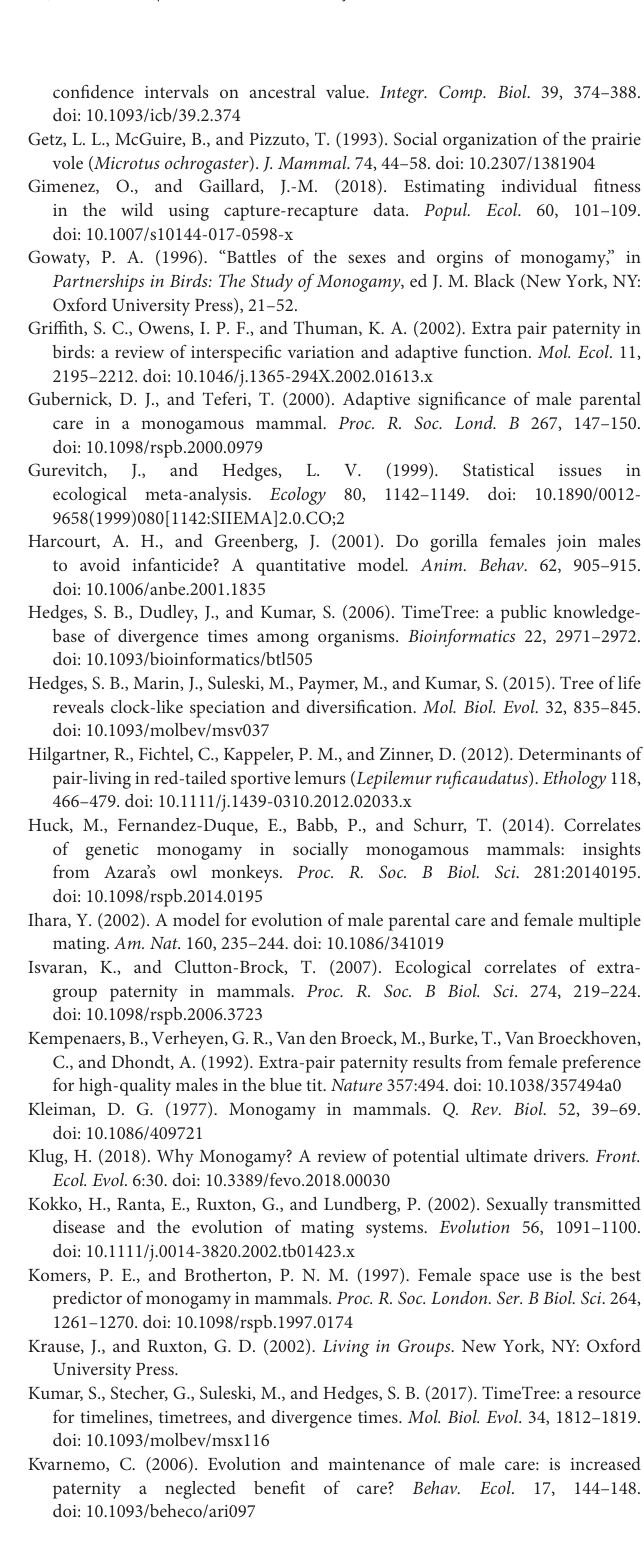
Supplementary Data Sheet 1 | This data sheet contains a list of all the species used in our analysis, the indices of genetic monogamy calculated from parentage data for each species, and the seven variables used in our analyses for each species, along with all the references for these.